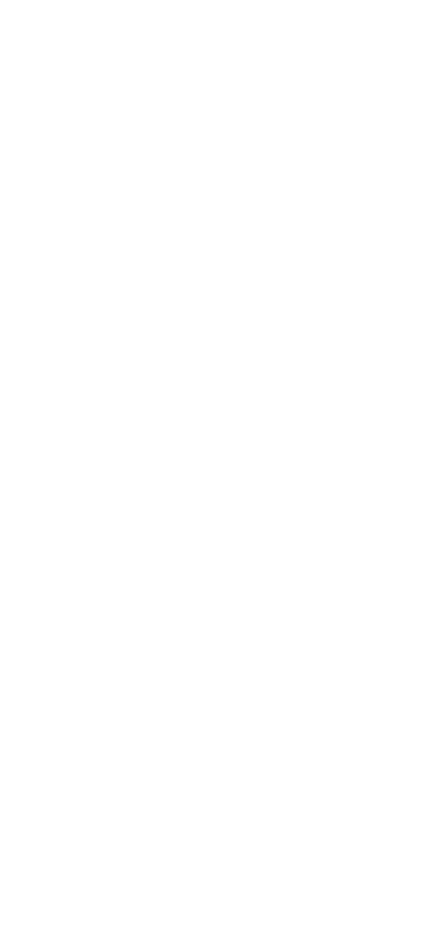
Figure 3 ( a ) The classic CS solution; ( b ) the ROECS solution; ( c ) the error between the ROECS solution and the CS solution when t =